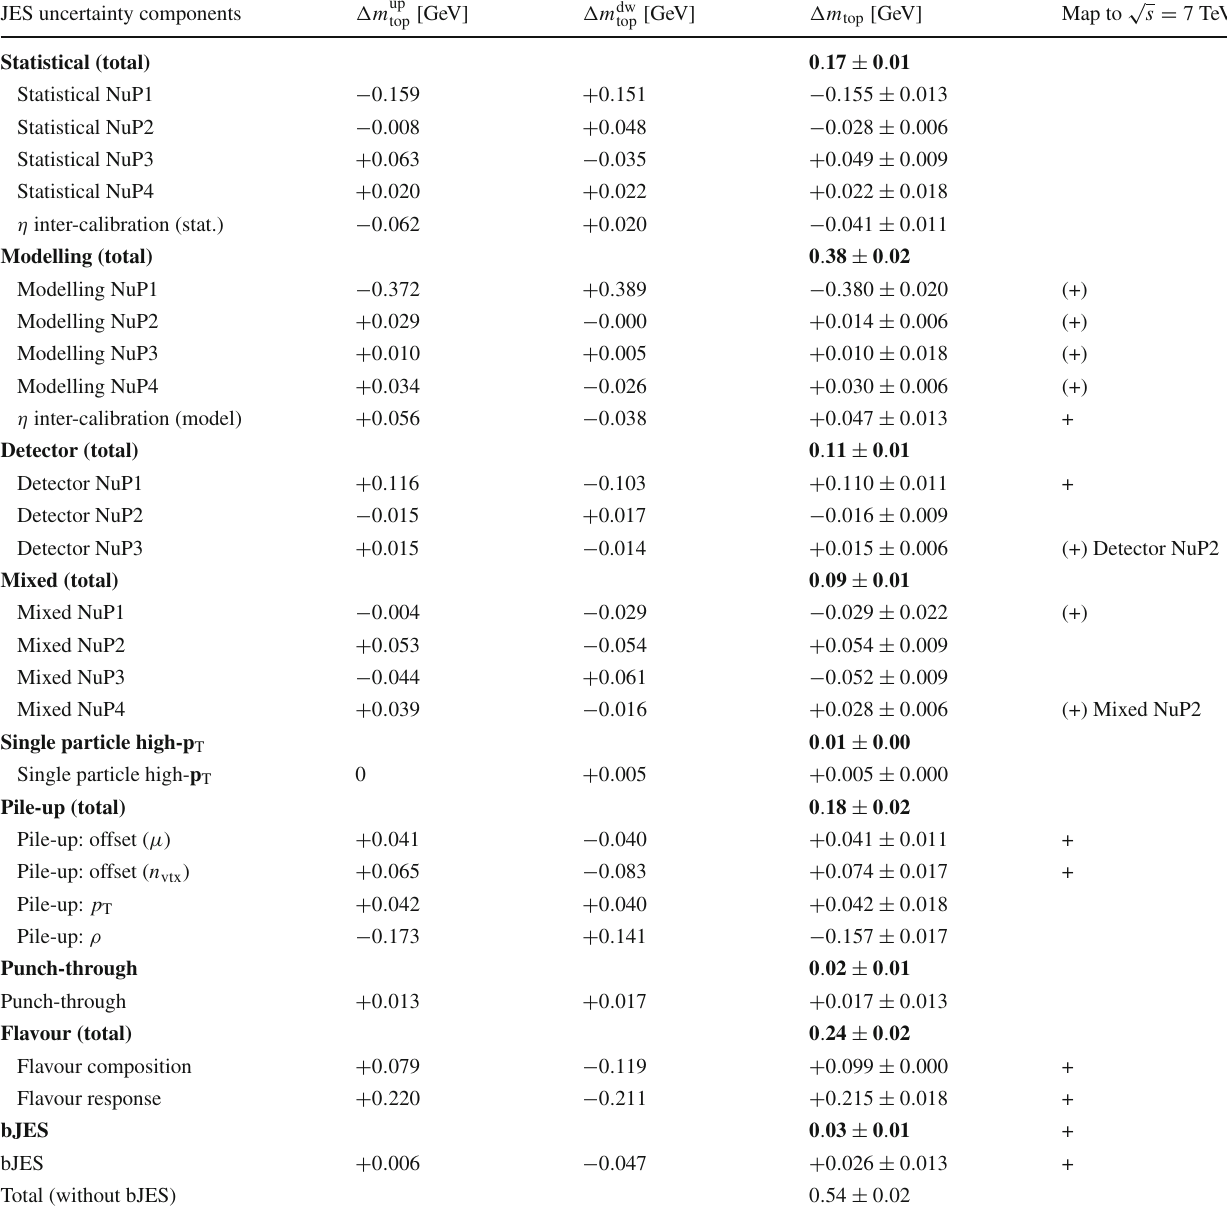
√ Table10 TheindividualcomponentsoftheJESuncertaintyconsidered s = 7 TeV data is given for the weak and the strong corre- used for √ s = 8 TeV, the resulting JES- for the t ¯ t → lepton + jets analysis at lation scenarios. The ‘+’ sign indicates corresponding components at the two centre-of-mass energies for the weak and strong scenario, while and bJES-uncertainty-induced shifts in m top and the final uncertainty the ‘(+)’ sign indicates components that only correspond for the strong in m top . The components [63] together with their statistical precisions scenario. Finally, mentioning a name indicates that the mapped sources are listed in boldface and, wherever applicable, calculated as the sum in √ s = 7 and 8 TeV. The uncertainty compo- carry different names at quadrature of the respective subcomponents. A shift listed as ‘0’ means that the corresponding variation resulted in an unchanged event sample. nents and the total uncertainty are given with 0.01 GeV precision. The Uncertainties quoted as 0.00 (0.000) are smaller than 0.005 (0.0005). term nuisance parameter is denoted by NuP . The last line refers to In the rightmost column, the mapping to the uncertainty components